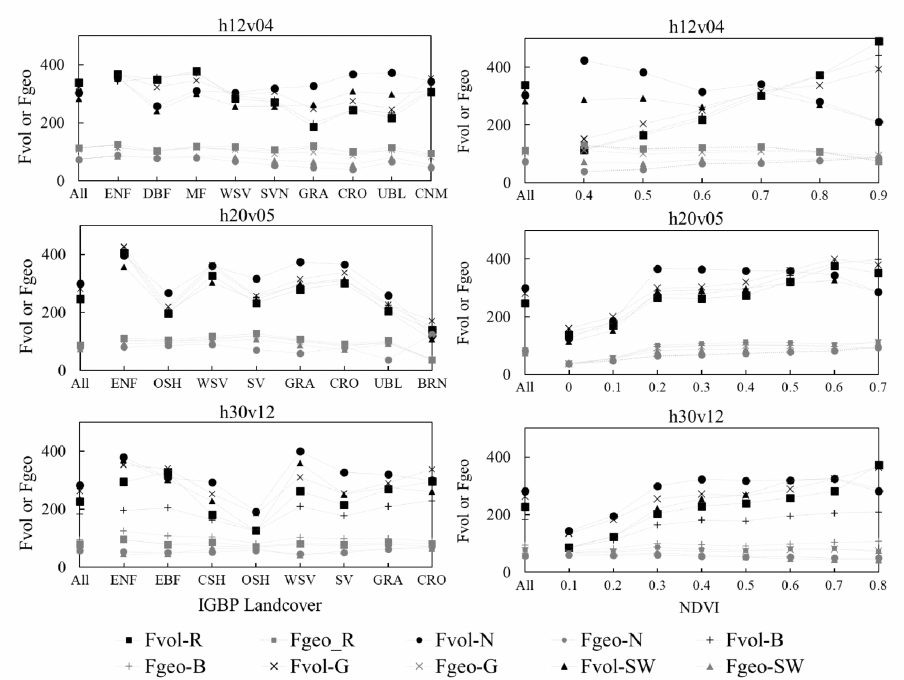
Figure 6. F , F L , and F N extracted from the high-quality MODIS dataset in the three tiles for red (R), near-infrared (N), blue (B), green (G), and shortwave broadband (SW).